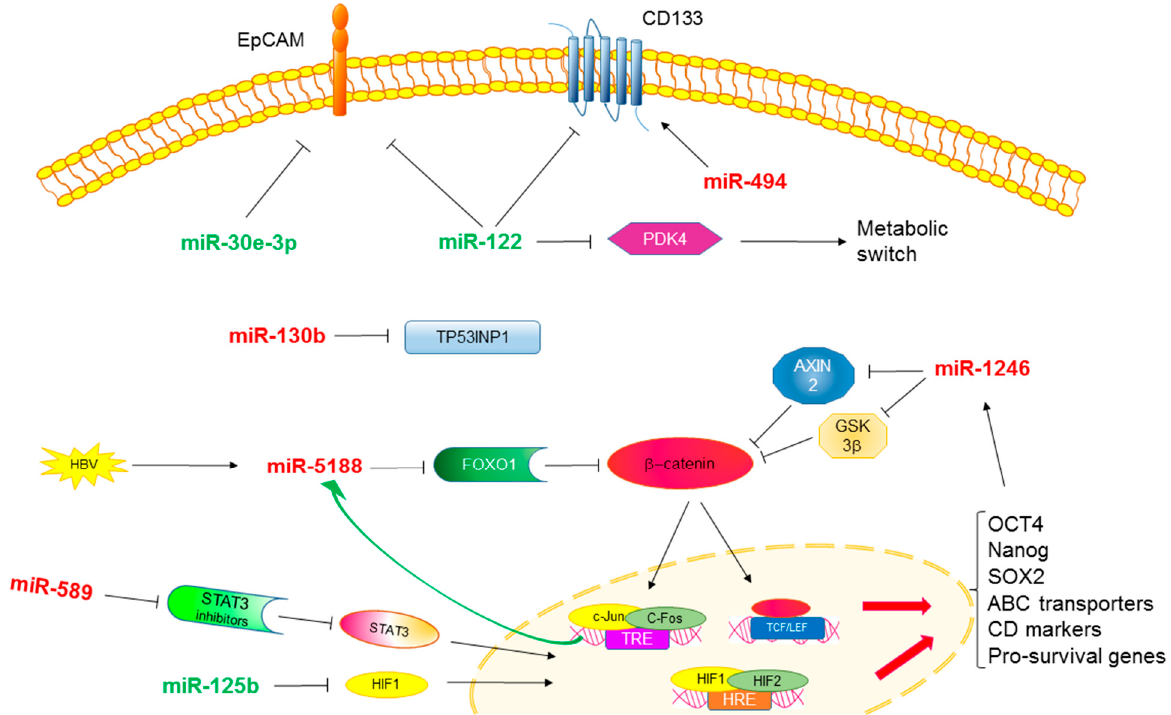
Figure 1. MicroRNAs and CSCs in HCC. Regulation of stemness molecules and pathways by tumor-specific miRNAs, leading to transcriptional activation of pro-survival genes and stemness-associated genes in HCC.